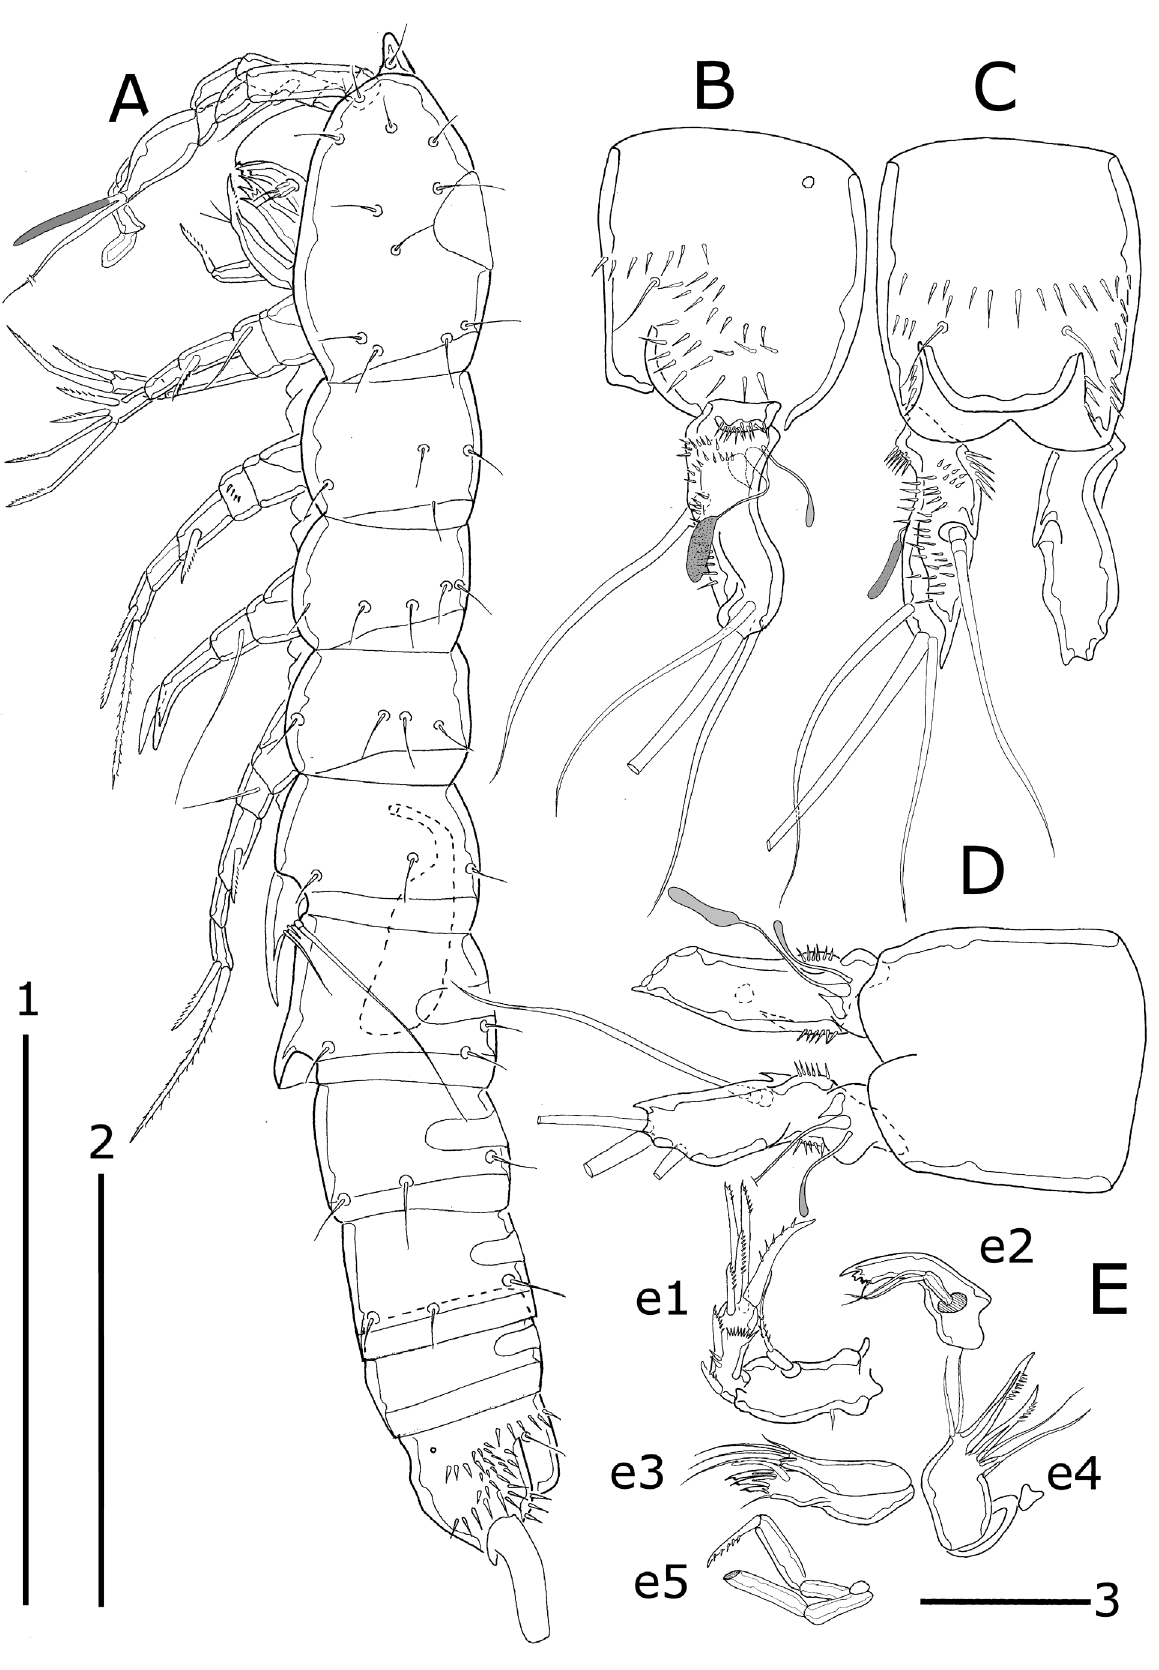
Figure 2. Eirinicaris antonioi sp. n. Male: A habitus, lateral view; B anal somite with caudal furca, lateral view; C anal somite with caudal furca, dorsal view; D anal somite with caudal furca, ventral view; E mouthparts; e1 antennule; e2 mandible; e3 maxillulae; e4 maxillae; e5 maxilliped. Scale bars: 1 = 50 µm ( A ); 2 ( B, C, D ) = 50 µm; 3 ( E ) = 20